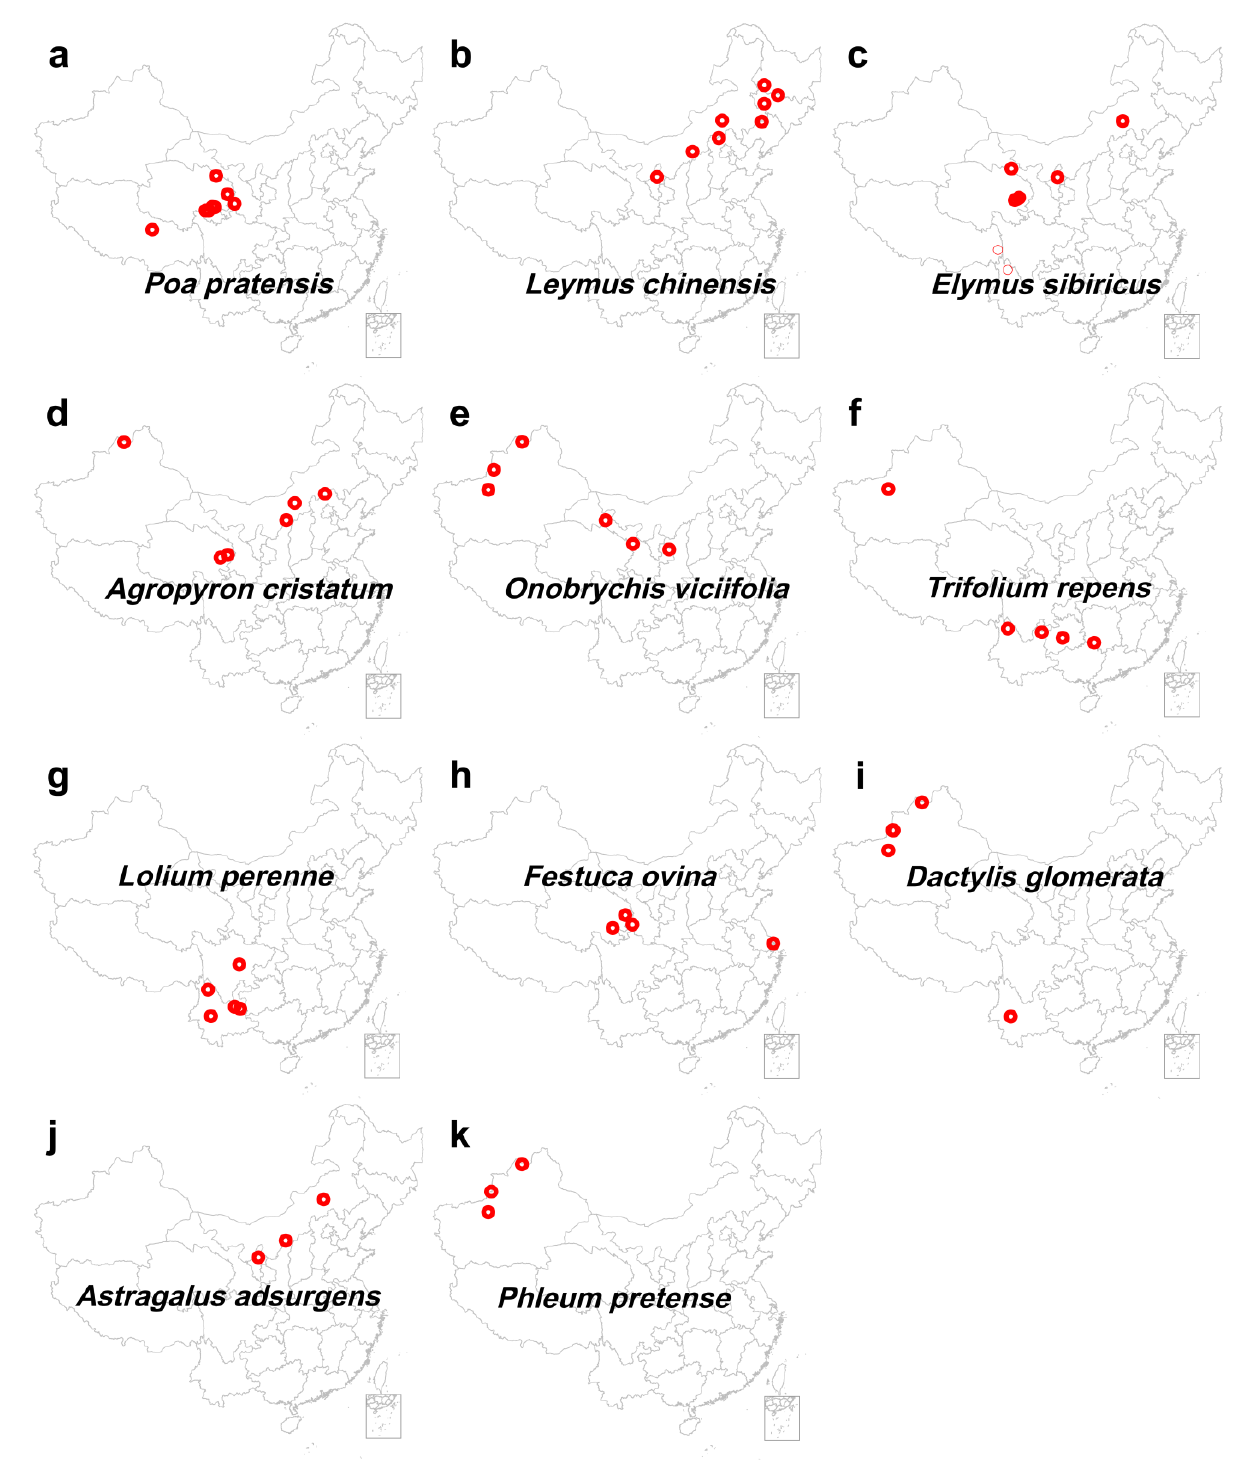
Figure A2. Spatial distribution of the 11 plant species other than those top three species presented in Figure A1.